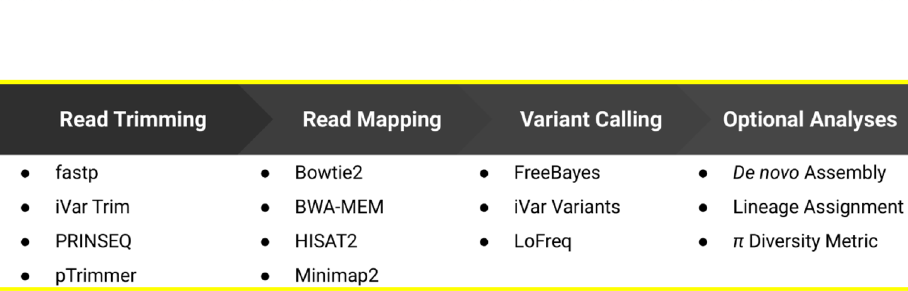
Table 1. Pipeline comparison. Bold denotes analyses that are optional in ViReflow.